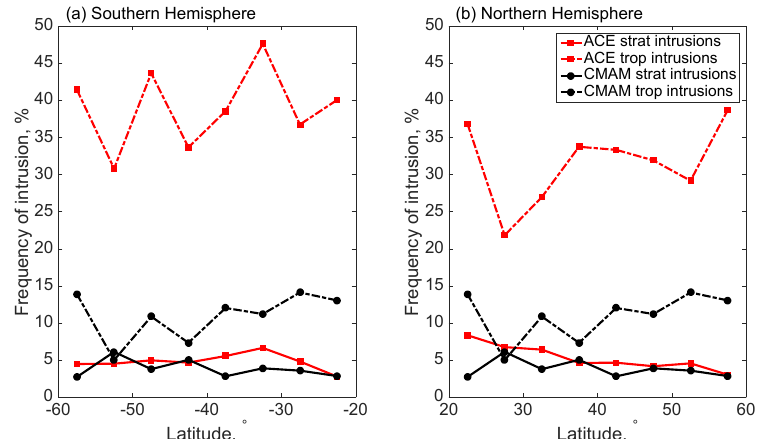
Figure 11. The frequency of intrusion across the tropopause for both CMAM30HR (black circles) and ACE-FTS (red squares) below the 420K potential temperature isotherm in (a) the southern hemispheric and (b) the northern hemispheric extratropical region between 20 and 60 ◦ N/S, respectively. For each 5 ◦ latitude bin, the frequency of intrusion events are separated by stratospheric intrusions (solid lines), where stratospheric-like air is found in the troposphere, and tropospheric intrusions (dashed lines), where tropospheric-like air is found in the stratosphere.